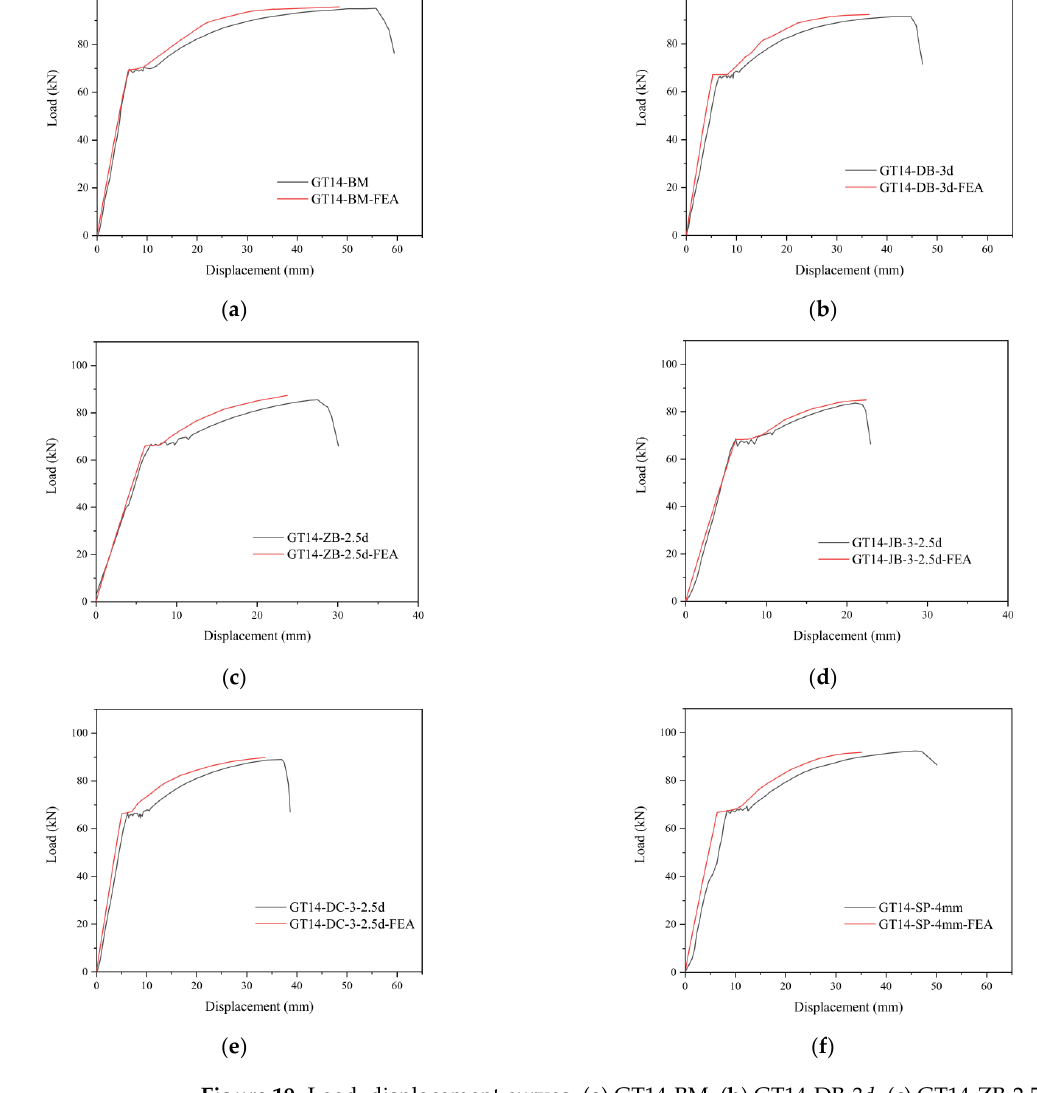
Table 11. Comparison between experimental and simulated eigenvalues.